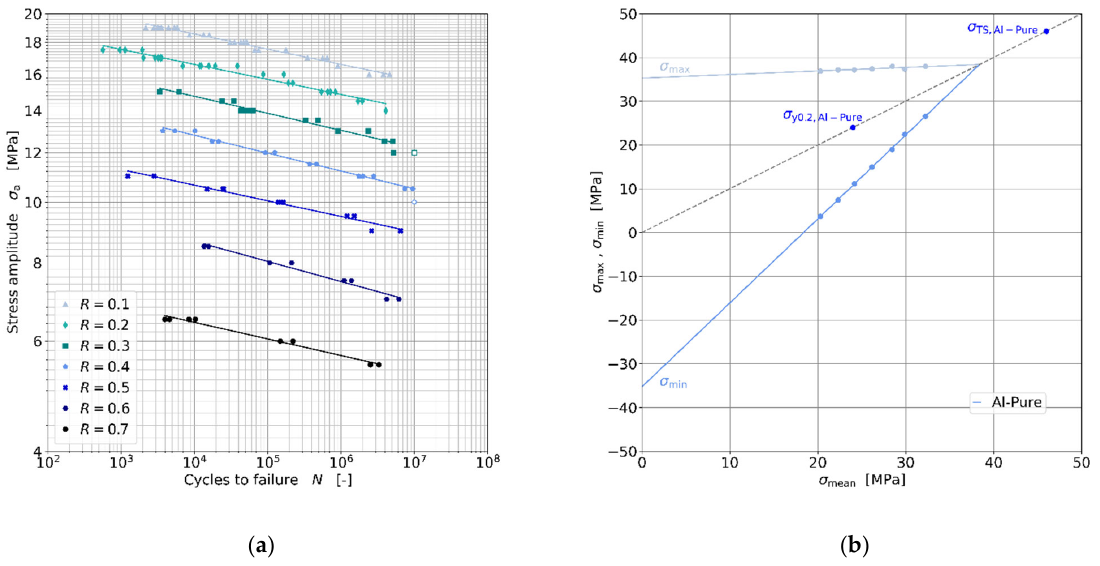
Figure 4. Wöhler diagram of Al ‐ Pure at 40 Hz with R ‐ ratios between 0.1 and 0.7 ( a ), Smith diagram of Al ‐ Pure at 1,000,000 cycles with R ‐ ratios between 0.1 and 0.7 ( b ).